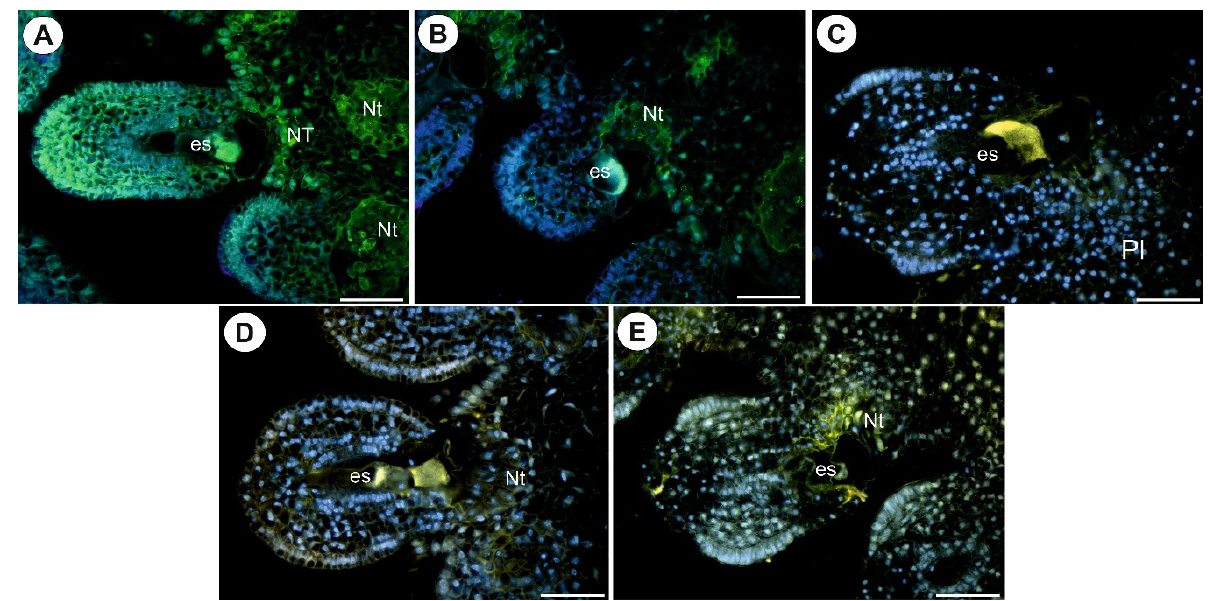
Figure 8. Arabinogalactan proteins (labeled with LM2) detected in Utricularia nelumbifolia and Utricularia humboldtii after fertilization. Control reactions of the immunolabeling of cell wall components. ( A , B ) Arabinogalactan proteins (labeled with LM2) detected in U. nelumbifolia ; embryo sac (es), nutritive tissue (Nt). ( C ) Arabinogalactan proteins (labeled with LM2) detected in U. humboldtii , note no positive signal; embryo sac (es), placenta (Pl); yellowish signal is autofluorescence. ( D ) Ovule of U. nelumbifolia ; embryo sac (es), nutritive tissue (Nt); yellowish signal is autofluorescence. ( E ) Ovule of U. humboldtii ; embryo sac (es), nutritive tissue (Nt); yellowish signal is autofluorescence. All bars 50 µm.